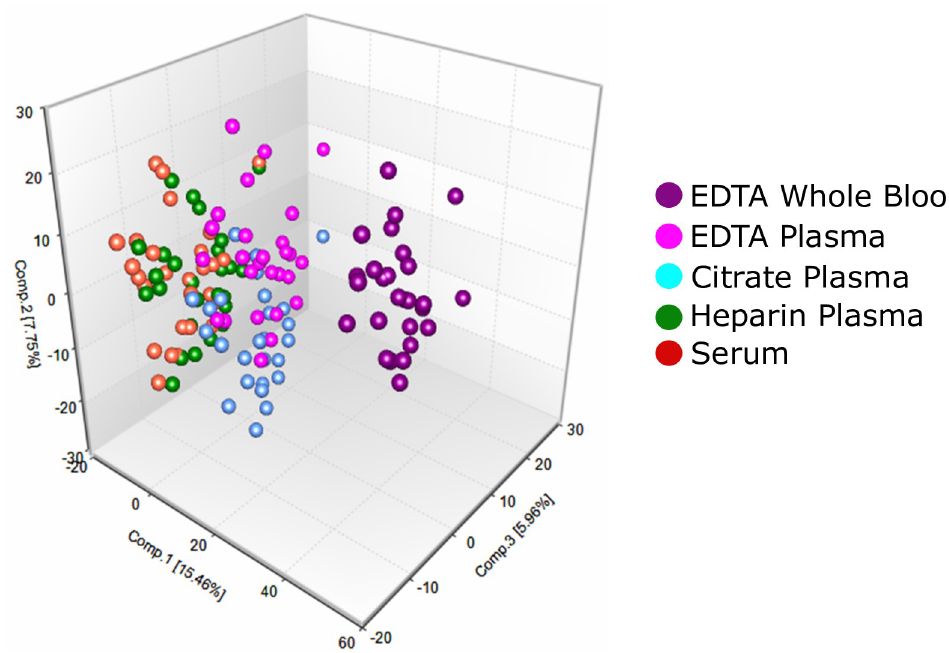
Fig 1. Unsupervised statistical analysis for all samples. Principal component analysis of the five sample types. Dark Purple indicates the EDTA anticoagulated whole blood samples; light purple—EDTA plasma samples, light blue—citrate plasma; green—heparinized plasma, and orange—serum samples.